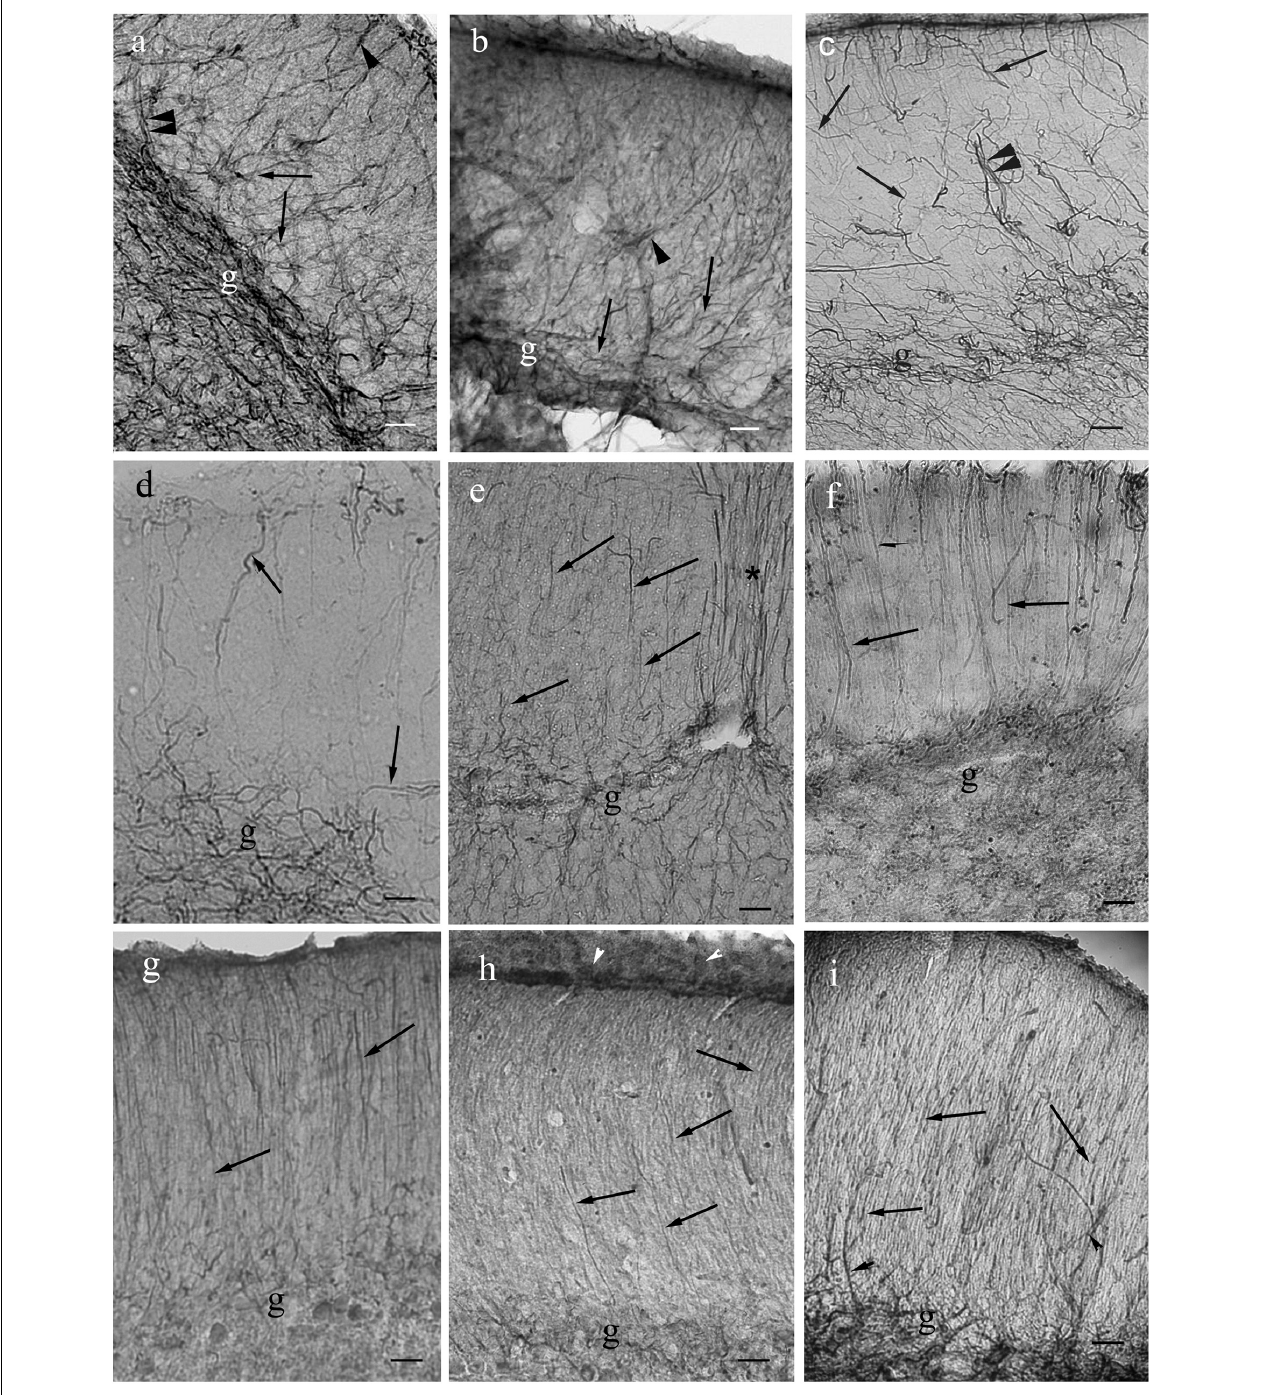
FIGURE 12 | Cerebella in Ostariophysi and Euteleostei. For the positions of the areas see the sketch in the previous figure (panel Figure11f ). The meningeal surfaces are upward. Arrows: glial processes; g: granular layer. The coarse (arrowheads), sometimes duplicated (double arrowheads) GFAP-immunopositive lines are most probably vessels (see in carp, Kálmán, 1998). No Bergmann-like process system is recognizable in Cypriniformes (panels a–d ). If fine processes are observed (arrows) they are not parallel with each other. In catfish (panel e ) and Euteleostei (panels f–i ) Bergmann-like processes (arrows) are recognizable. (a) Goldfish. Scale bar: 100 µ m. (b) Bream. Scale bar: 100 µ m. (c) Carp. Scale bar: 100 µ m. (d) Bleak. Scale bar: 100 µ m. (e) Catfish. Asterisk: the thick process population in the midline. Scale bars: 80 µ m. (f) Trout. Scale bar: 80 µ m. (g) Perch. Scale bar: 80 µ m. (h) Sander. Arrowheads: meningeal glial end-feet. Scale bar: 80 µ m. (i) Lemon cichlid. Scale bar: 60 µ